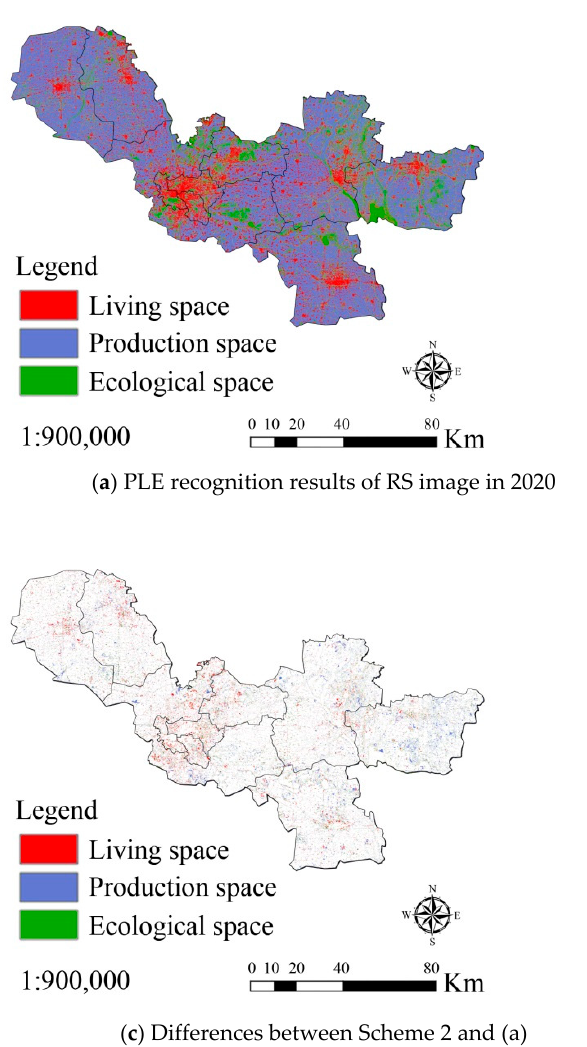
Figure 5. Differences between PLE space evolution predictions from three experimental schemes and that determined from remote sensing image recognition in Xuzhou, China in